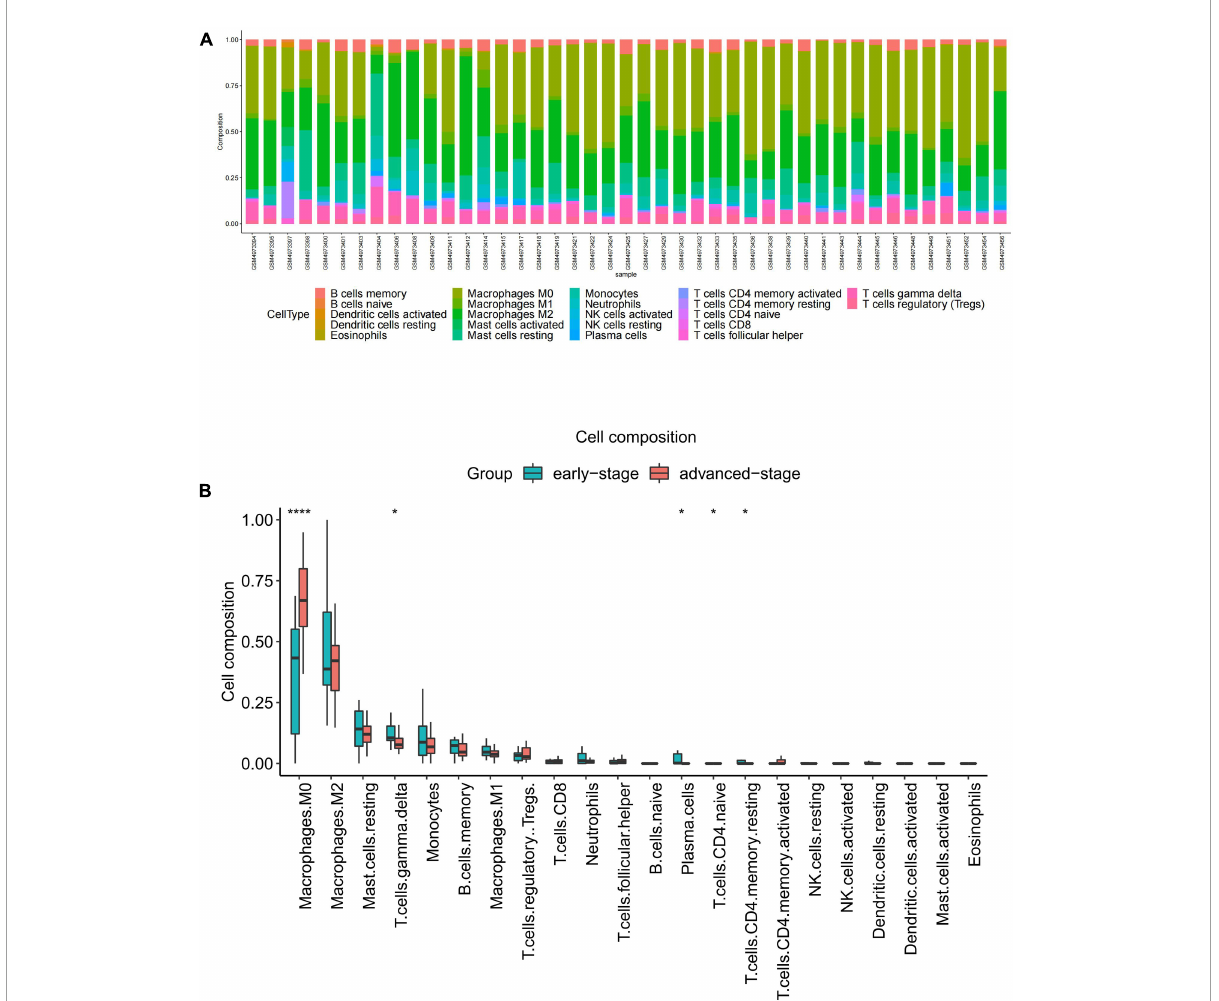
FIGURE4 Immune cell Infiltration and evaluation in carotid atherosclerotic plaque samples. (A) Relative proportion of immune infiltration of 22 immune cell types in carotid atherosclerotic plaques samples. (B) The differential expression of 22 immune cells in the early-stage and advanced-stage carotid plaque samples. Significance level was denoted by * p -value < 0.05, ** p -value < 0.01, *** p -value <